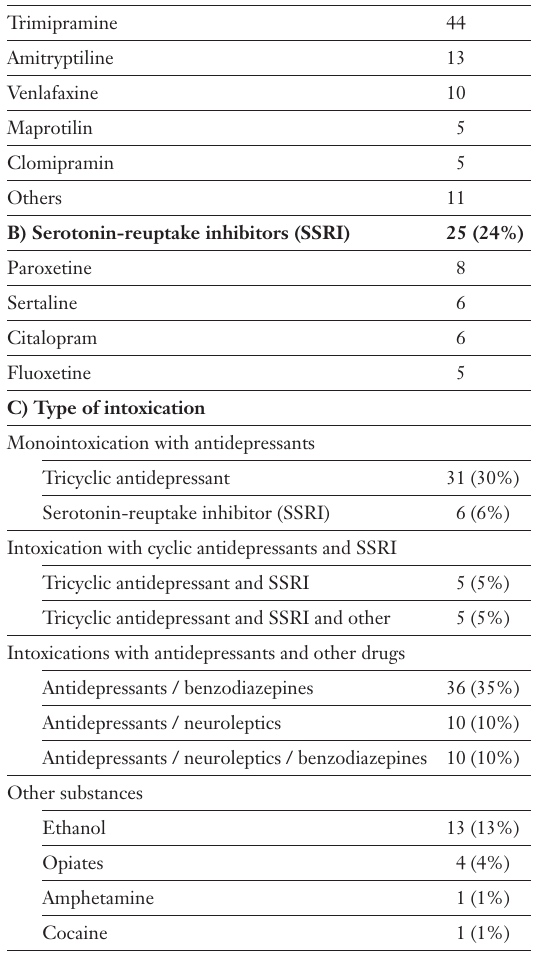
Table 4 Drugs identified in 103 patients with presumed antide- pressant